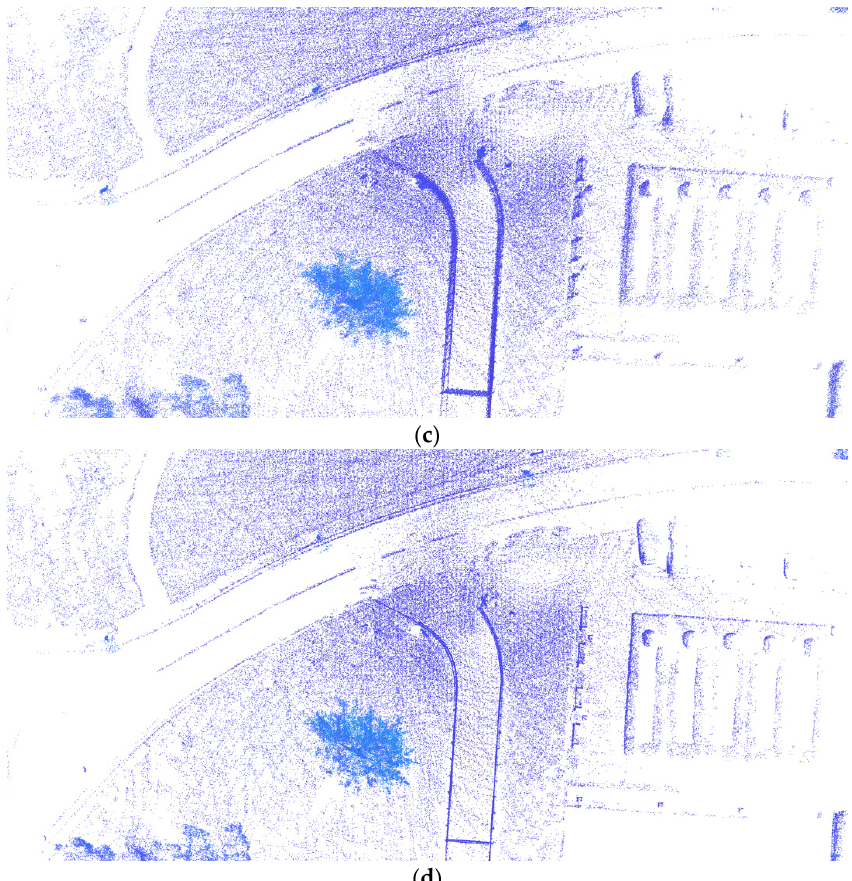
Figure 11. Comparison of a local magnification of the submaps in scene 5. ( a ) The local magnification of the submap in scene 5 with the ICP method. ( b ) The local magnification of the submap in scene 5 with the NICP method. ( c ) The local magnification of the submap in scene 5 with the IMU-aided ICP method. ( d ) The local magnification of the submap in scene 5 with our method.